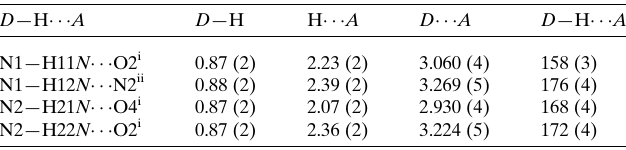
Table 1 Hydrogen-bond geometry (A˚ , (cid:2) ).